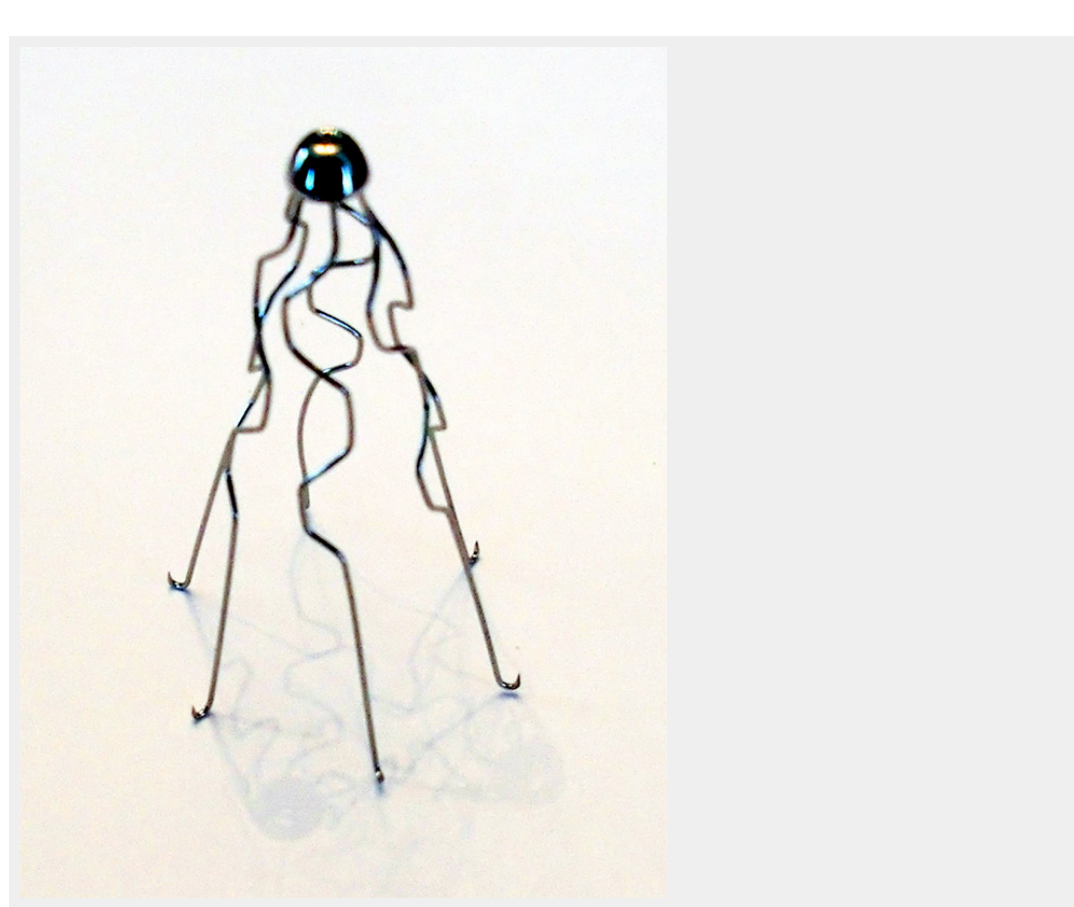
Original Greenfield vena cava filter (catalog no. 2846). This device was designed for permanent implantation including sharp hooks at the bottom to prevent migration. In contrast, retrievable caval filters have a hook or a graspable area at the tip that allows for traction and refolding into a